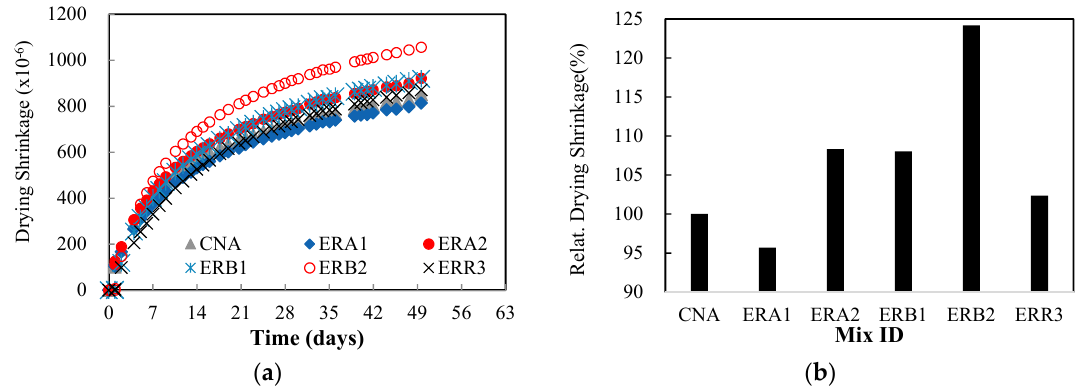
Figure 10. Test results of drying shrinkage of concrete samples ( a ) shrinkage, ( b ) relative value. Using the ACI equation [49], the drying shrinkage difference between the ERA1 and ERA2 mixes can be analyzed. Influencing factors are air content, slump, cement contents, and fine aggregate